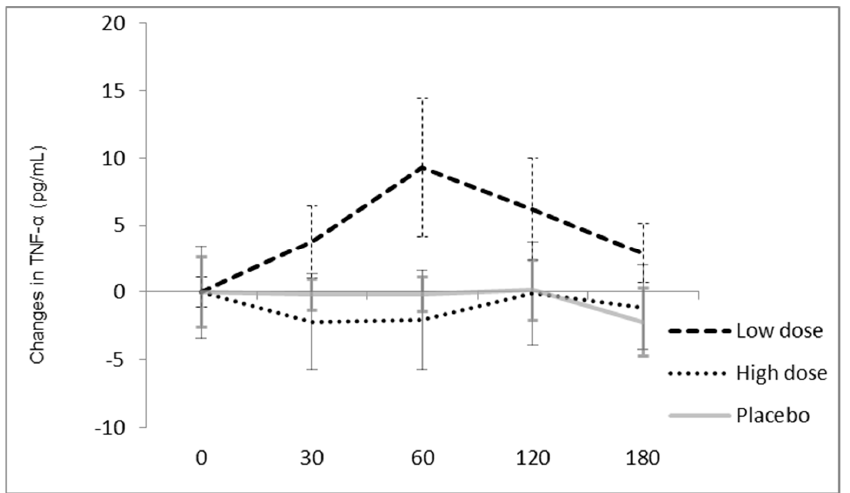
Figure 4. Variation in serum TNF α concentration at time points of 30, 60, 120 and 180 min after eating a high-fat meal in individuals with dyslipidemia, where n = 13. Values are expressed as mean and standard error of the mean, represented by the error bars. TNF α = tumor necrosis factor